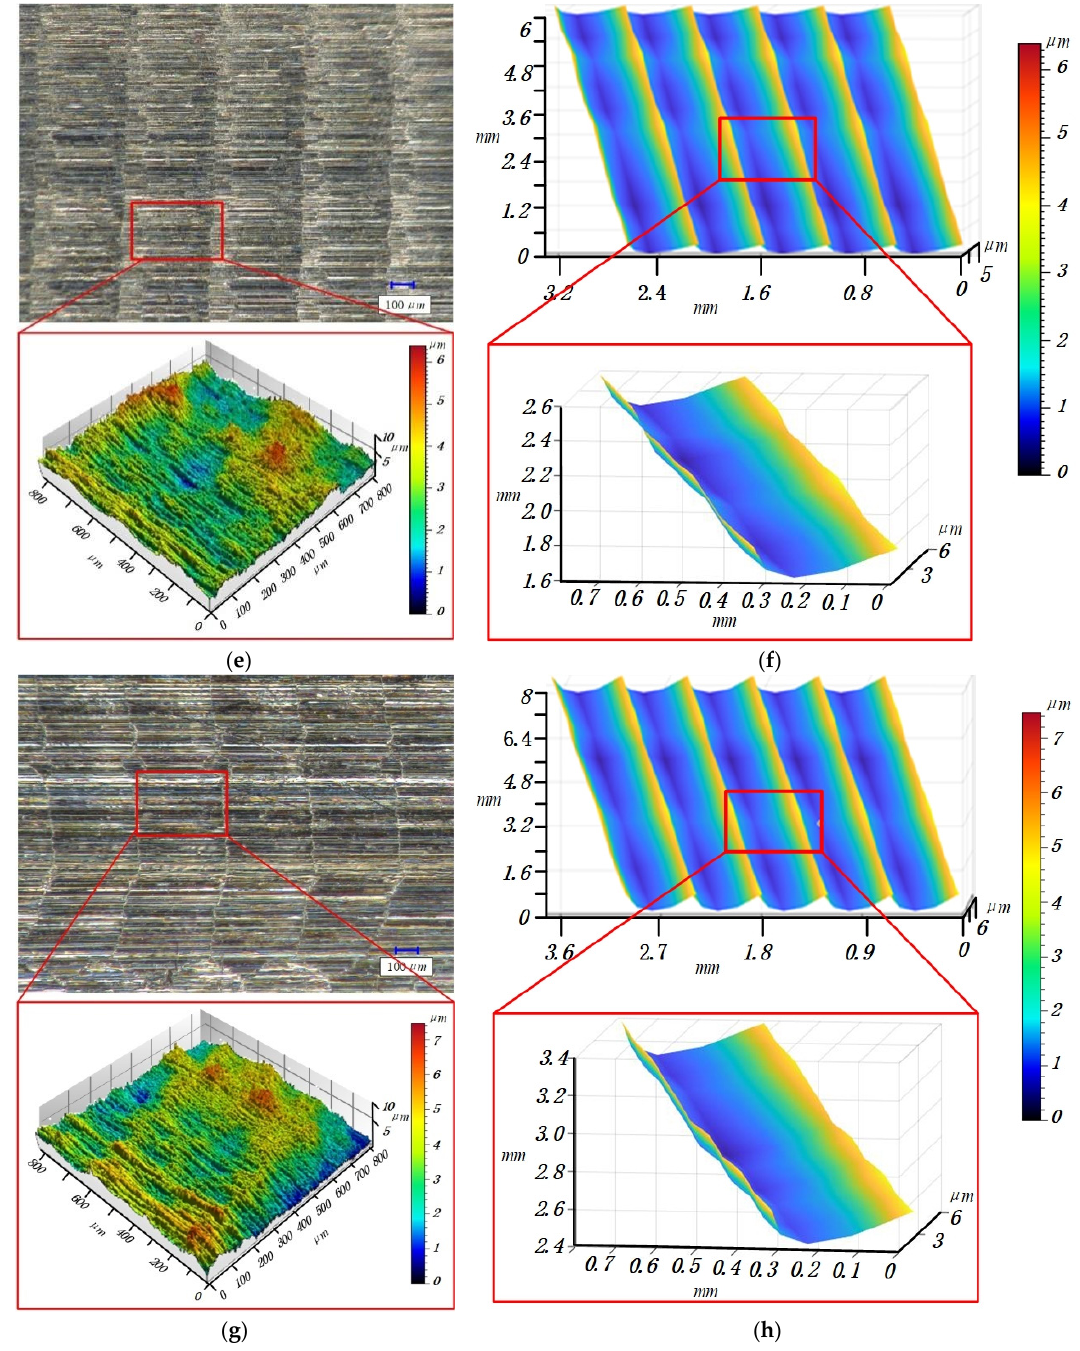
Figure 13. Measured ( a , c , e , g ) and simulated ( b , d , f , h ) surface topographies in Table 2. ( a ) The 1st set of measurement topography. ( b ) The 1st set of simulation topography. ( c ) The 2nd set of measurement topography. ( d ) The 2nd set of simulation topography. ( e ) The 3rd set of measurement topography. ( f ) The 3rd set of simulation topography. ( g ) The 4th set of measurement topography. ( h ) The 4th set of simulation topography.